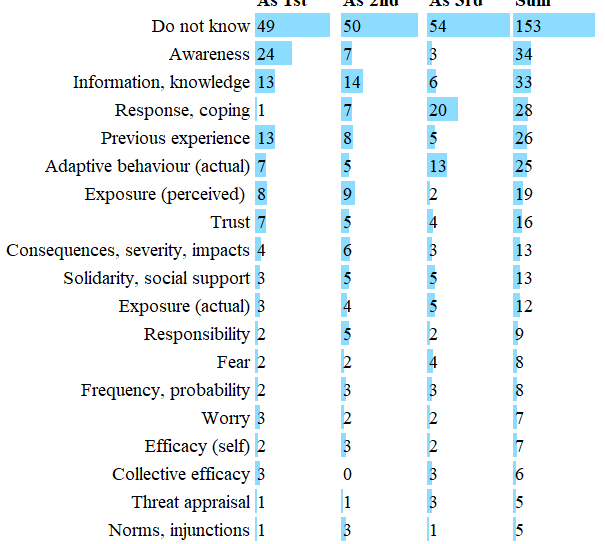
Figure 5. Responses to “From your experience, what would be the three decisive questions or themes for cross-study comparability?” Only items with five or more responses are